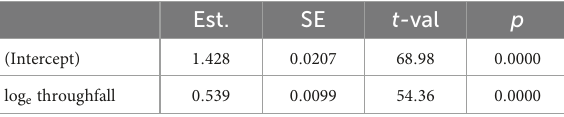
TABLE 2 Regression output of the final selected